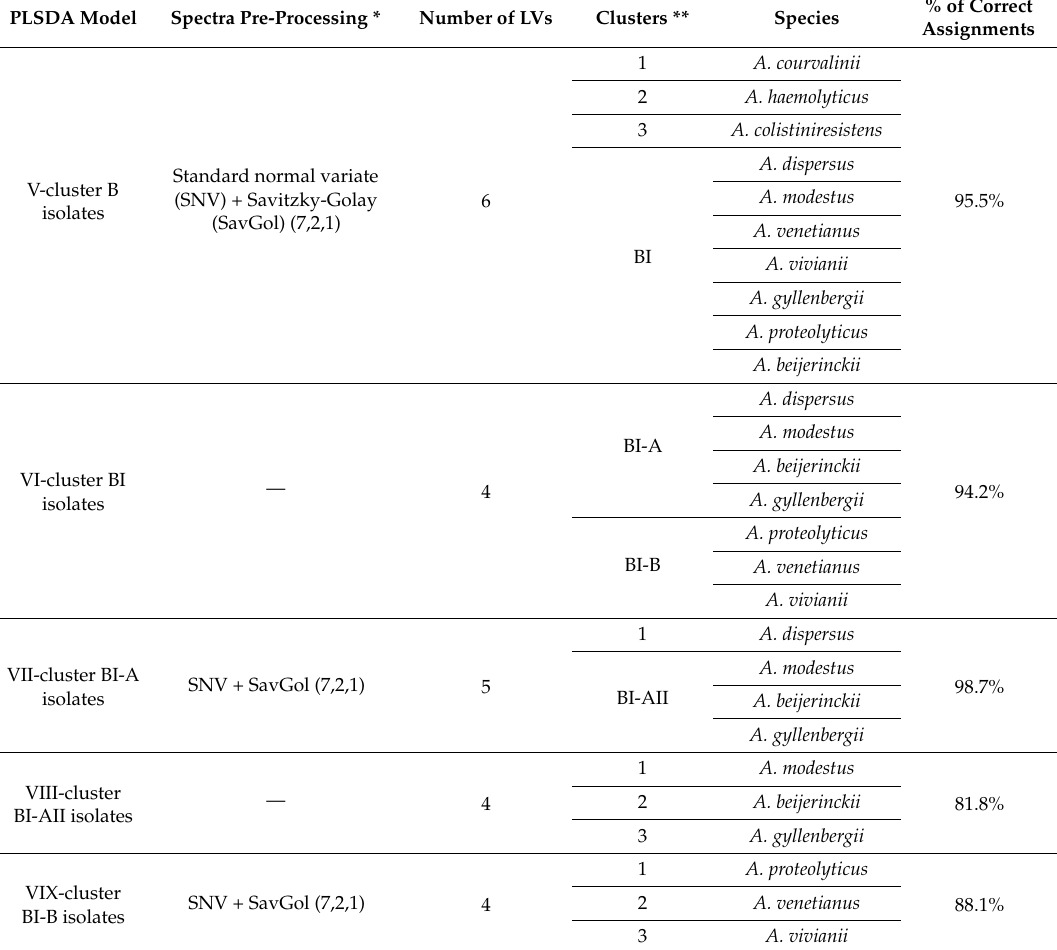
Table 3. Details of the PLSDA models developed for Cluster B Acinetobacter species